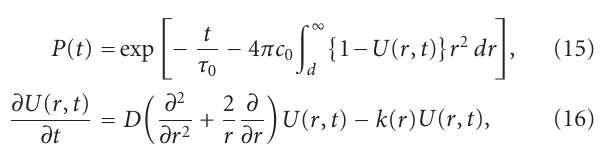
Table 1: Parameters R 0 and k 0 determined by analyzing the fluores- cence decay curves. E f ∞ /eV − Δ G AN /eV R 0 / ˚A k 0 /s − 1 C153-TMPD(0.2M) 0.92 0.78 11.1 2 . 9 × 10 10 C522-TMPD(0.2M) 0.81 0.89 12.2 3 . 7 × 10 10 C152-TMPD(0.2M) 0.63